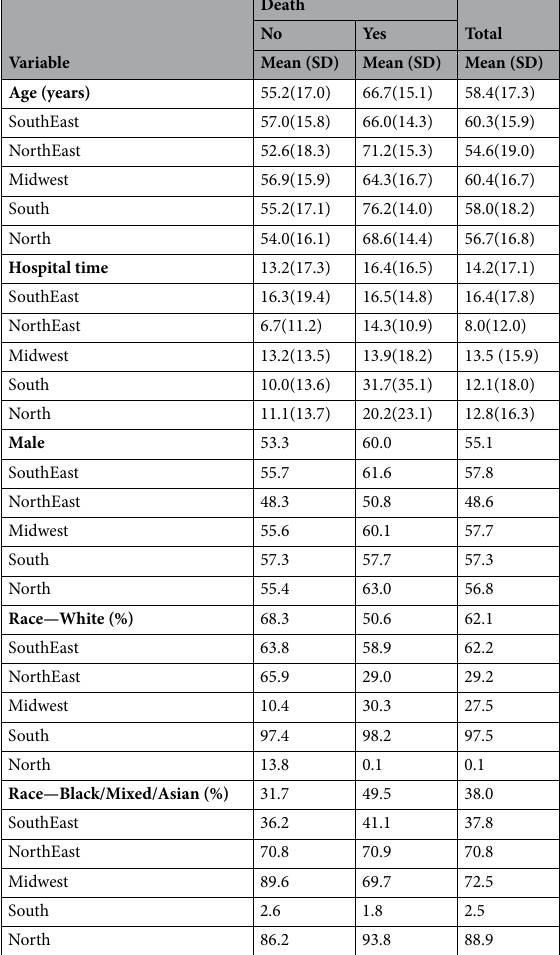
Table 1. Descriptive statistics of the demographics characteristics of the